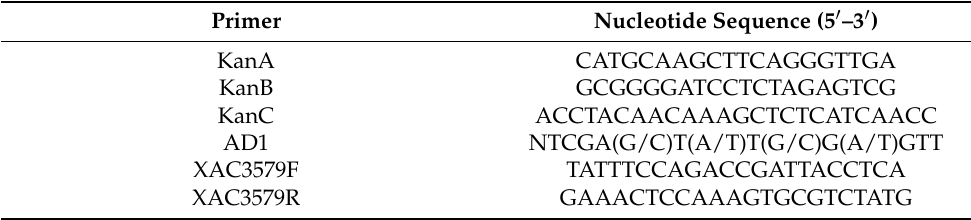
Table 1. Primers used to transposon insertion point confirmation.